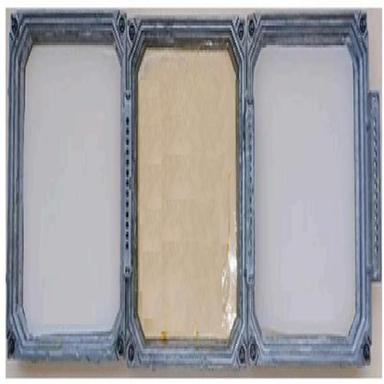
Molds to produce the boluses plates (sheets).